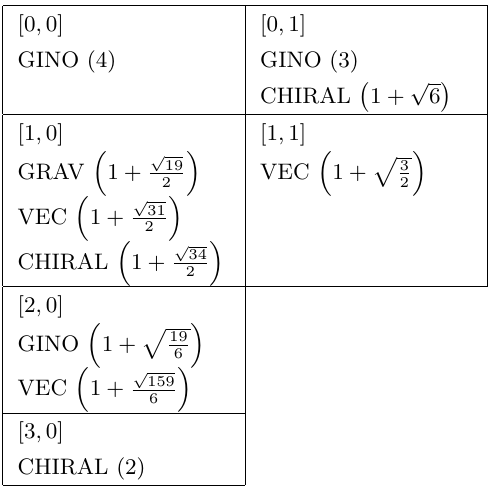
Table 8 . Supermultiplets at KK level n = 1 for the N = 1 G 2 -invariant AdS 4 solution of type